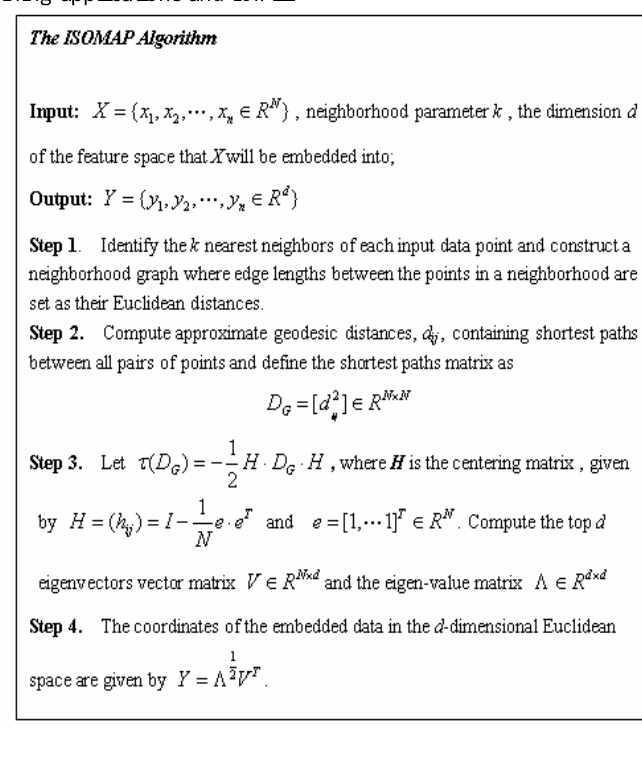
Fig.1 The ISOMAP